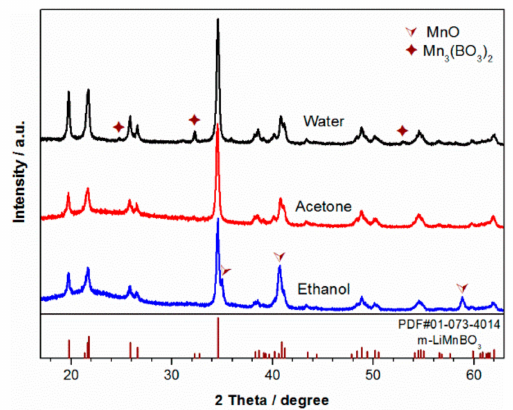
Figure 2. XRD patterns of LiMnBO 3 prepared by ball-milling the raw materials with PVP in di ff erent